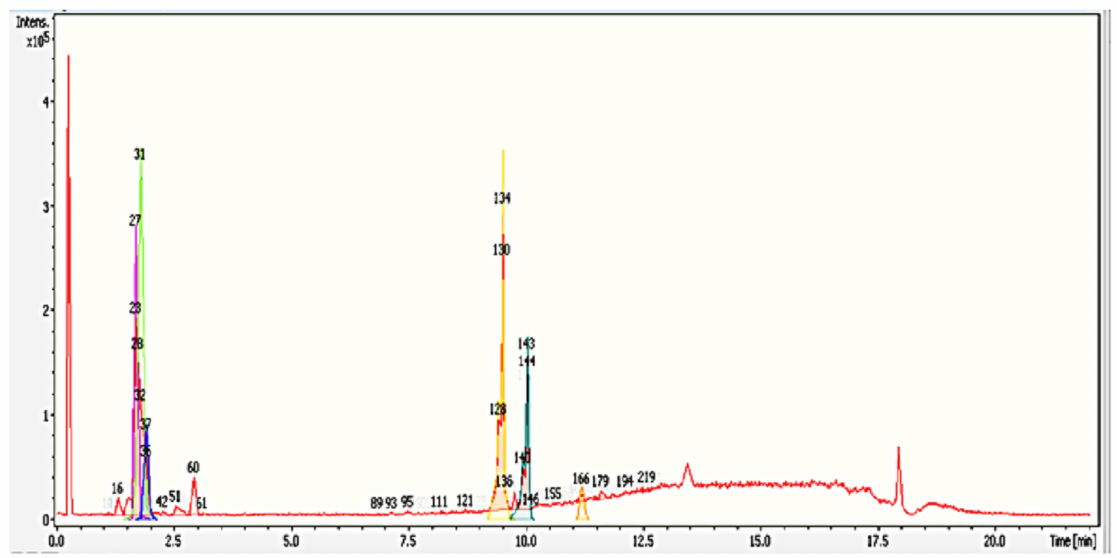
Figure 6. Base peak chromatogram (BPC) (red color) and dissect chromatograms (di ff erent colors) of the G0R3 37–41 fraction by Liquid Chromatography-Time of Flight-Mass Spectrometry (LC-MS-TOF) in a positive ionization mode. Peak labeling with di ff erent numbers represent the compounds identified that correspond to Table 3. Bruker’s dissect algorithm in Data Analysis software 4.0 allows the user to observe overlapping peaks at very similar retention